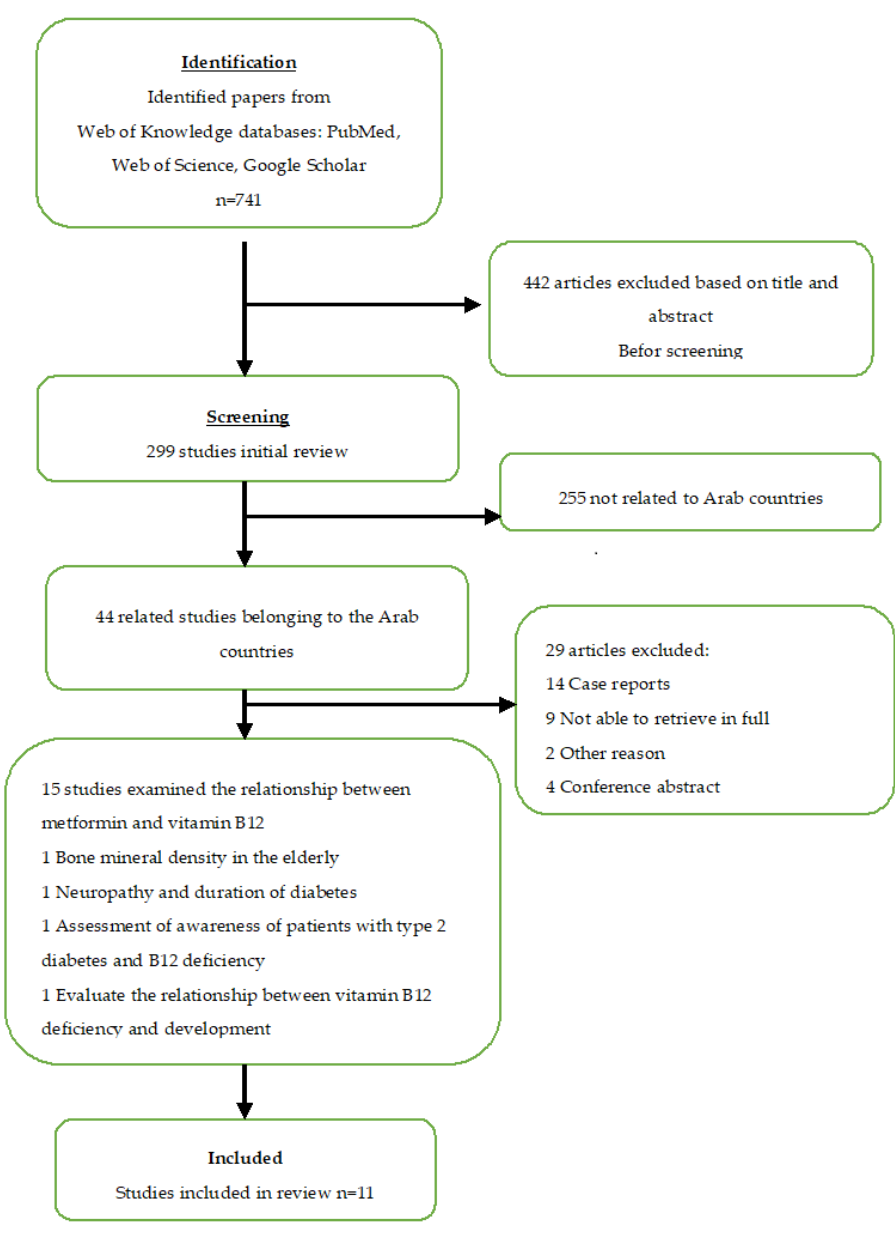
Figure 1. Research scheme and exclusion criteria.